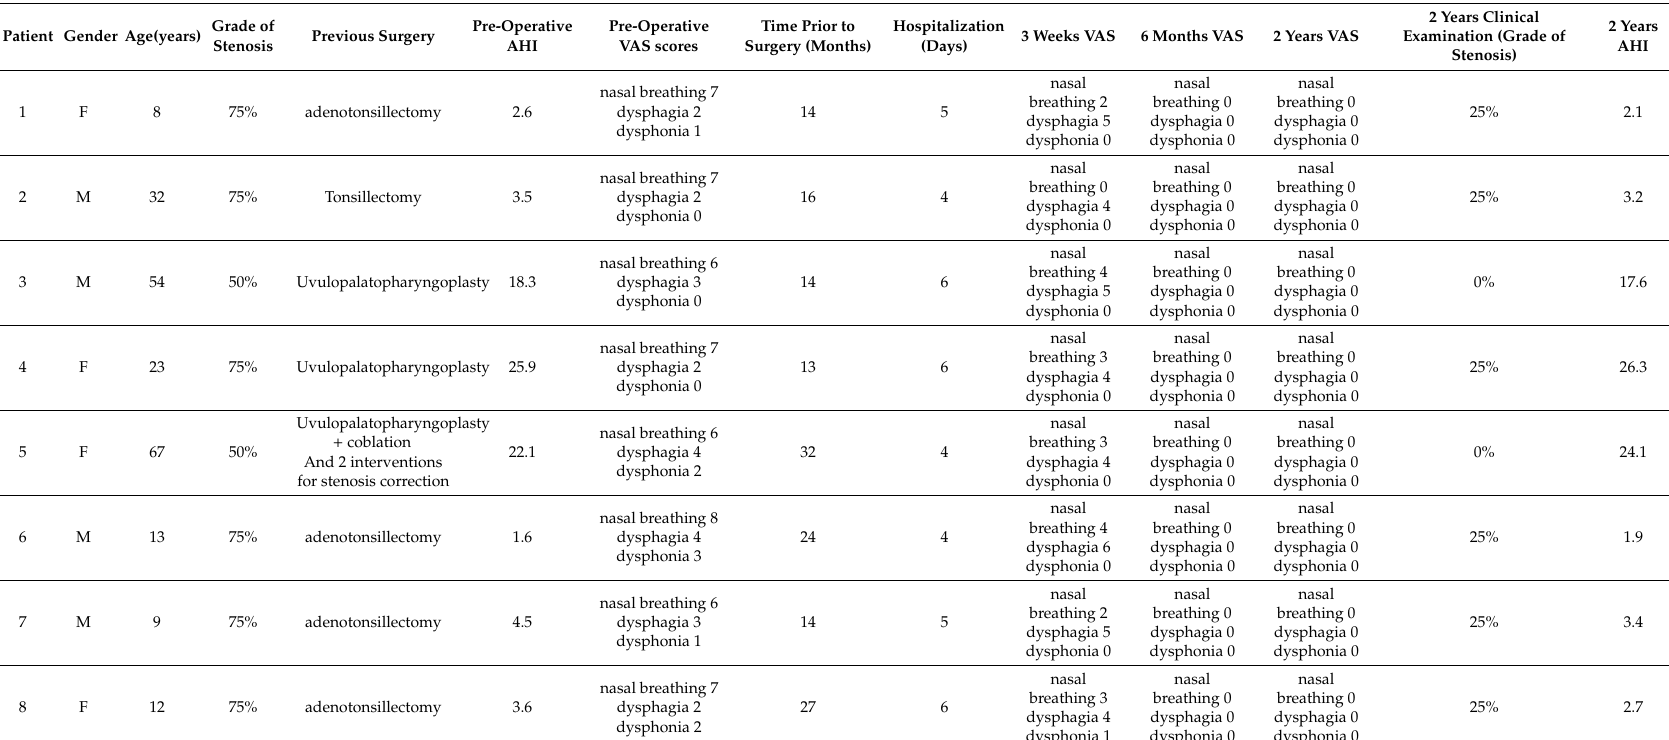
Table 1. Table summarizing clinical data about the